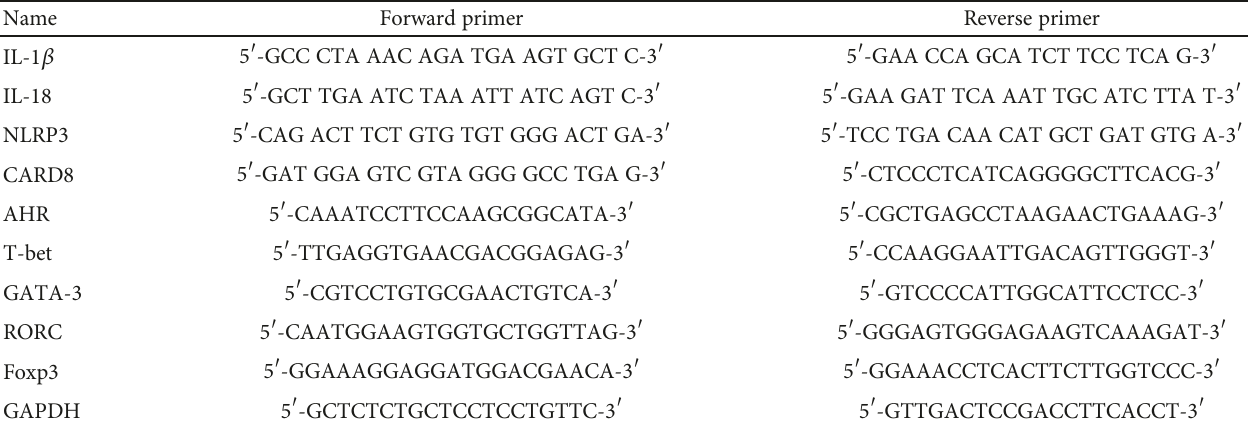
Table 2: Primer sequences.